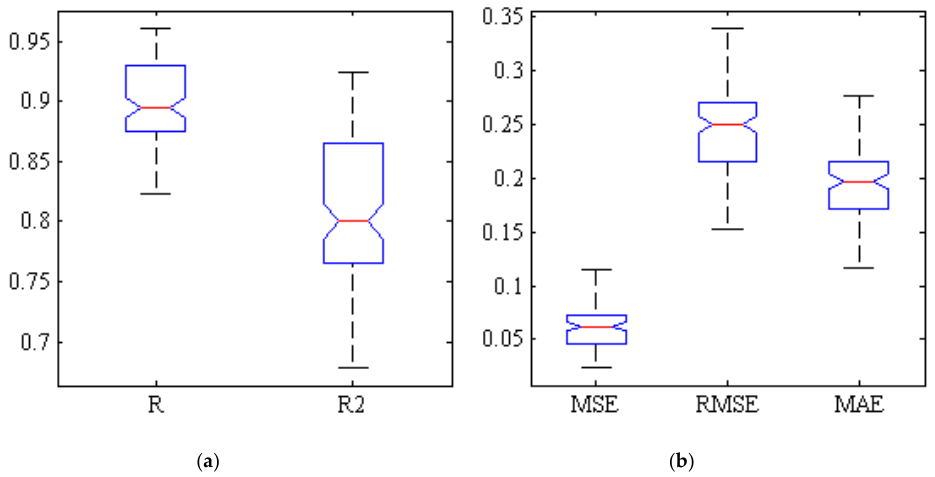
Figure 10. Box diagram of five criteria for evaluation of ANN-BBO performance in estimating TSS of